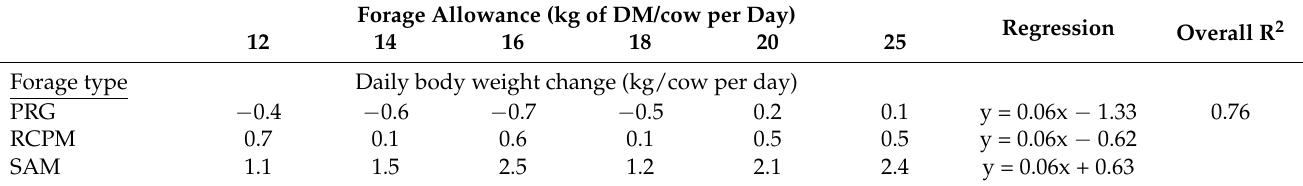
Table 3. Daily body weight change of early lactation dairy cows grazing three different forage types at six forage allowances. Forage types included PRG, perennial ryegrass monoculture; RCPM, perennial ryegrass, white clover and plantain mixture; and SAM, spatially adjacent monocultures of perennial ryegrass, white clover and plantain. As forage type significantly improved the variance accounted for by the model, separate forage type relationships are shown for each forage type. Forage Allowance (kg of DM/cow per Day) Regression Overall R 2 12 Daily body weight change (kg/cow per